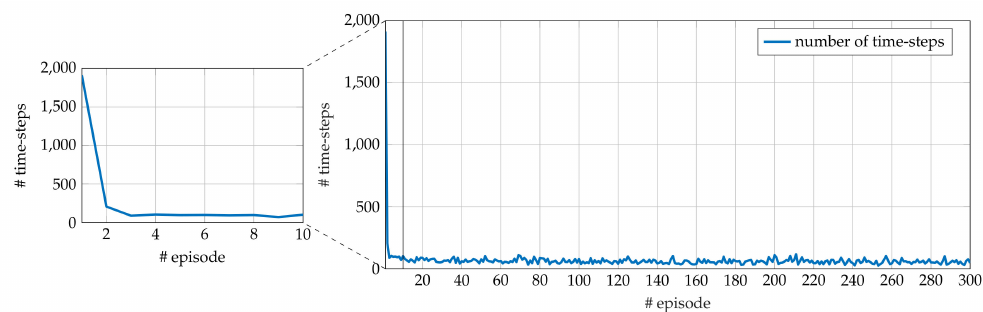
Figure 5. Number of time-steps for each episode during a single run of training performed on the FERMI FEL system. The number of time-steps required in the first 10 episodes is highlighted in the enlarged portion.